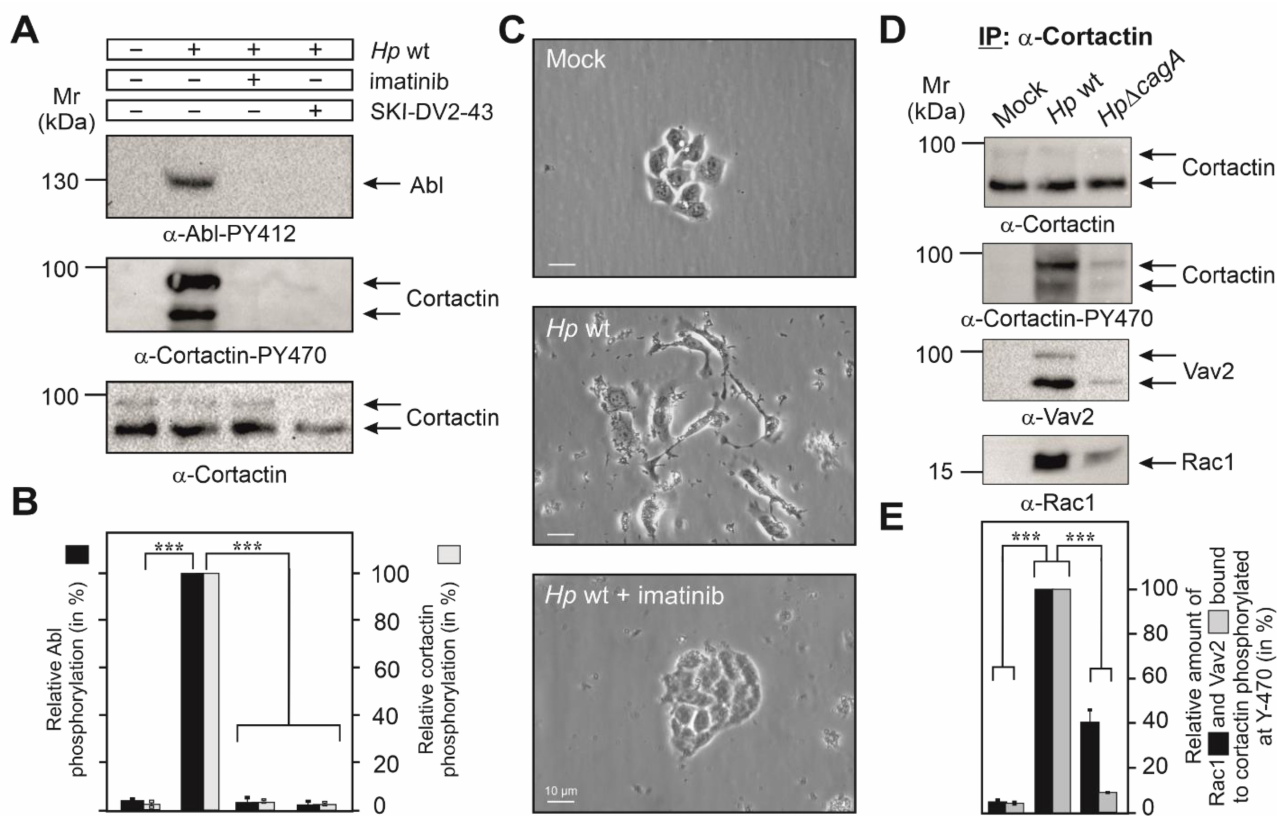
Figure 2. Cortactin Y-470 is phosphorylated by activated Abl kinase and forms a physical complex with Vav2 and Rac1, associated with cell motility. ( A ) AGS cells were infected for 6 h with H. pylori in the presence or absence of the Abl-specific inhibitors imatinib and SKI-DV2-43. Cell lysates were probed with indicated antibodies, demonstrating the activated Abl phosphorylated cortactin at Y-470 (arrows). ( B ) Densitometric quantification of phospho-band intensities for Abl (Y-412) and cortactin (Y-470). ( C ) Phase contrast microscopy revealed that H. pylori induces cell scattering, which is abolished by the Abl inhibitor imatinib. 400 × magnification, scale bars represent 10 µ m ( D ) AGS cells were co-incubated with wt H. pylori or ∆ cagA mutant for 6 h, followed by immunoprecipitation (IP) using cortactin antibodies. Resulting blots were probed with antibodies as indicated. The results show that cortactin phosphorylated at Y-470 interacts with Vav2 and Rac1 in a CagA-dependent manner. ( E ) Band intensities of Rac1 and Vav2 bound to phosphorylated cortactin were quantified using the Image Lab software version 6.1. Error bars represent +/ − SD. The results are from three independent experiments. p -values of ≤ 0.001 (***) were considered as statistically